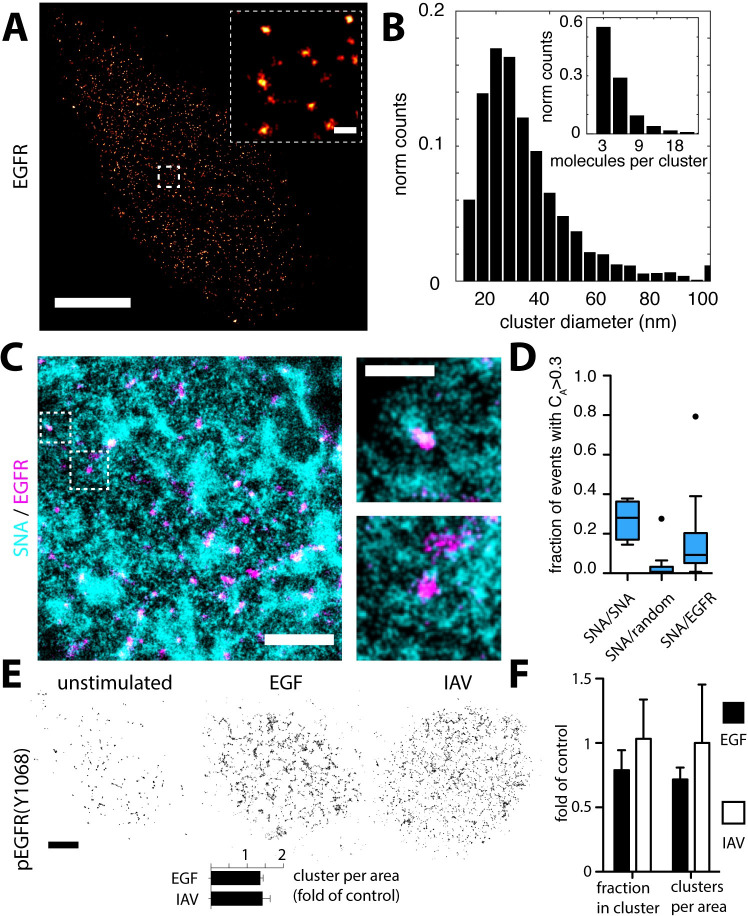
EGFR is organized in nanodomains that overlap with SNA domains.(A) A549 cells were labelled with antibodies against EGFR. STORM imaging revealed a clustered organization of EGFR. The clusters have an average diameter of 60 nm and contain about 5–10 molecules (B). Scale bar 1 μm. Inset: 100 nm. (C) Two-color STORM imaging of A549 cells labelled with SNA and anti-EGFR antibodies. The two panels on the right show larger magnification of the boxed areas in the left panel. Scale bars: 500 nm (left panel), 200 nm (right panel). The degree of colocalization was quantified using coordinate-based colocalization, where each localization is associated with a colocalization value CA. (D) Box plots of CA distribution of SNA localizations when colocalized with (1) SNA, (2) a random distribution of localizations at equal density as EGFR and (3) EGFR. After IAV-stimulation (MOI~100), we found that phosphorylated EGFR (Y1068) is also localized in nanodomains. Although a small population of clusters seems to be phosphorylated without stimulus, we observed an increase in the activated cluster population after stimulation with IAV (MOI~100) or EGF (100 ng/ml) (E, lower panel). To test for a potential redistribution of EGFR, we looked at the entire population after stimulation. While after EGF stimulation, we could observe a reduction of the clustered protein fraction as well as the cluster density per area, we could not detect such a protein redistribution after IAV stimulation (F).